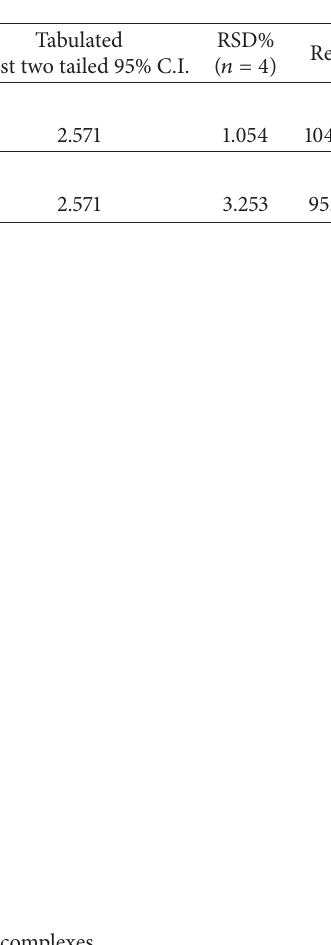
Table 5: Regression equation, correlation coefficient, 𝑡 -test concentration ranges, detection limits, RSD%, and recovery (rec.%) for the determination of TC-Au(III) complex by FAAS.